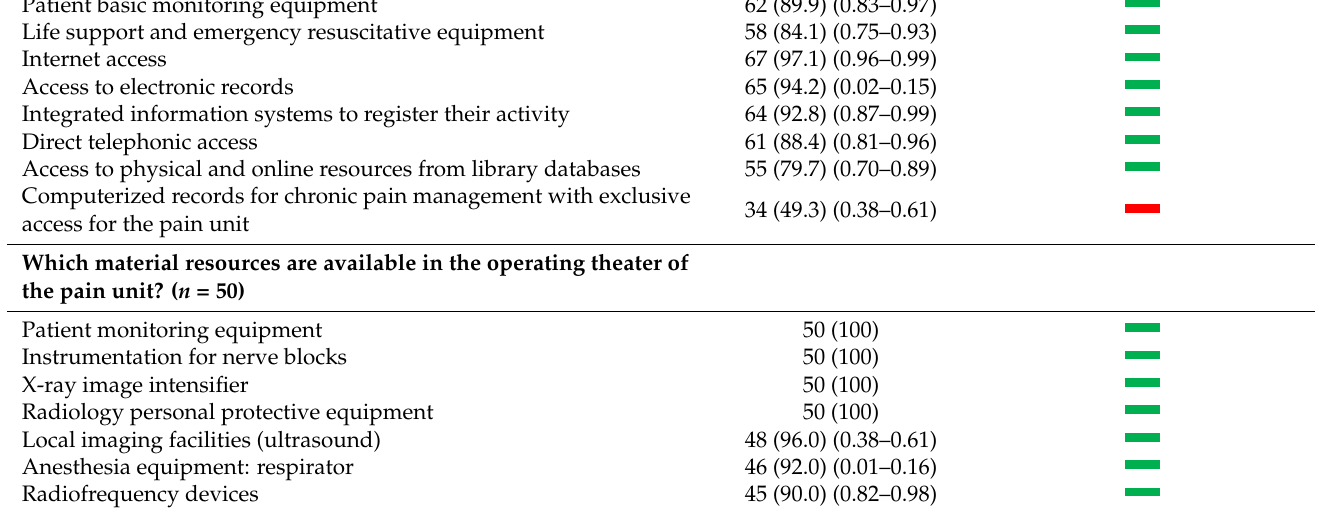
5 of 11 Table 1. Facilities and resources available in a sample of Spanish pain units in 2018. Units n (%) 95%CI Compliance with Spanish Standards FACILITIES ( n = 69) Which facilities are available at the pain clinic? Consultation/treatment rooms for ambulatory visits